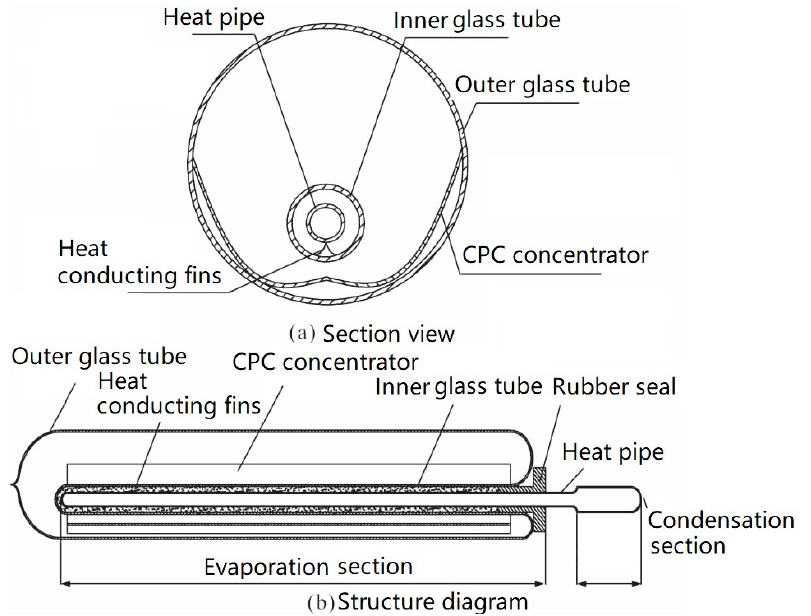
Figure 15. Schematic of an evacuated tube with internal CPC: ( a ) Cross-sectional view; ( b ) structure diagram [37].